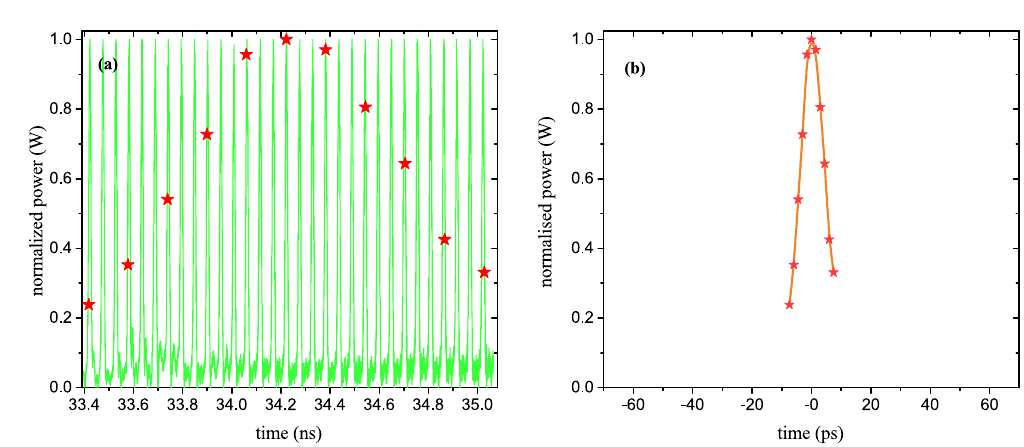
Figure 7. Sampled and stretched input pulse with a bandwidth of 100 GHz. ( a ) Post processed pulse copies (green) with a repetition rate of Δ f R = 18.774 GHz sampled with an effective sampling frequency of 6.2 GHz ( Δ f S = 12.4 GHz, blue dots). The stretching factor is Δ S = 108. ( b ) Reconstructed input pulse with an FWHM duration of 10.37